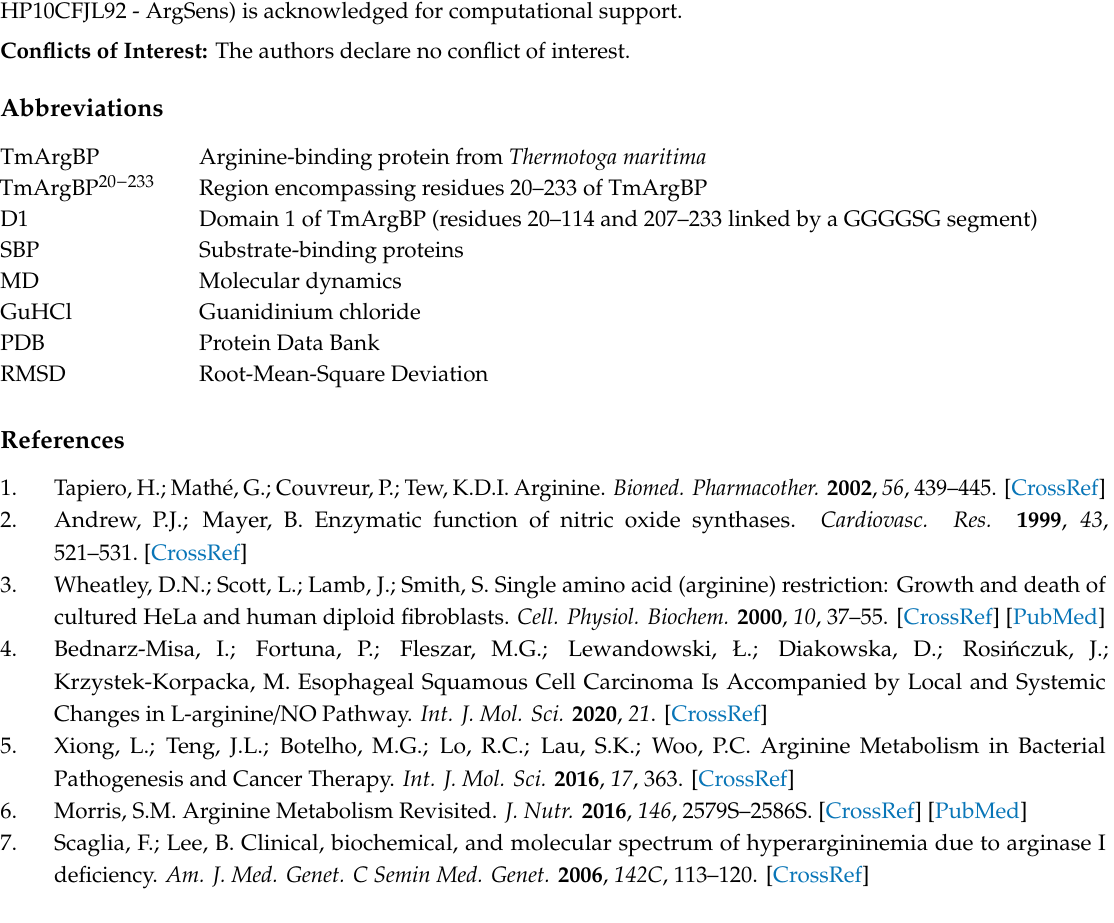
Figure S1: Amino acid sequence of the wild-type TmArgBP and of the two protein variants TmArgBP 20-233_F76W ; Figure S2: Cartoon representation of the crystal structure of the arginine-bound form of TmArgBP20-233; Figure S3: Modelling of the Phe76Trp mutation in the arginine-bound form of TmArgBP20-233; Figure S4: Stability of TmArgBP20-233_F76W in the MD simulation; Figure S5: MD simulation of TmArgBP 20-233_F76W ; Figure S6: Hydrophobic interactions in the MD simulation of TmArgBP 20-233_F76W ; Figure S7: Validation of the variability of geometrical parameters of the protein backbone in the crystallographic structure of TmArgBP D1 F57W ; Figure S8: Network of the interactions established by Arg with the protein residues in the crystal structure of D1 F57W ; Table S1: Results of the regression analysis of the variability of several bond angles. Table S2: Structural comparison of TmArgBP D1 F57W , D1 and TmArgBP 20-233 ; Table S3: Atoms of the arginine bound to TmArgBP D1 F57W that are closer than 4.0 Å to atoms of W57 side